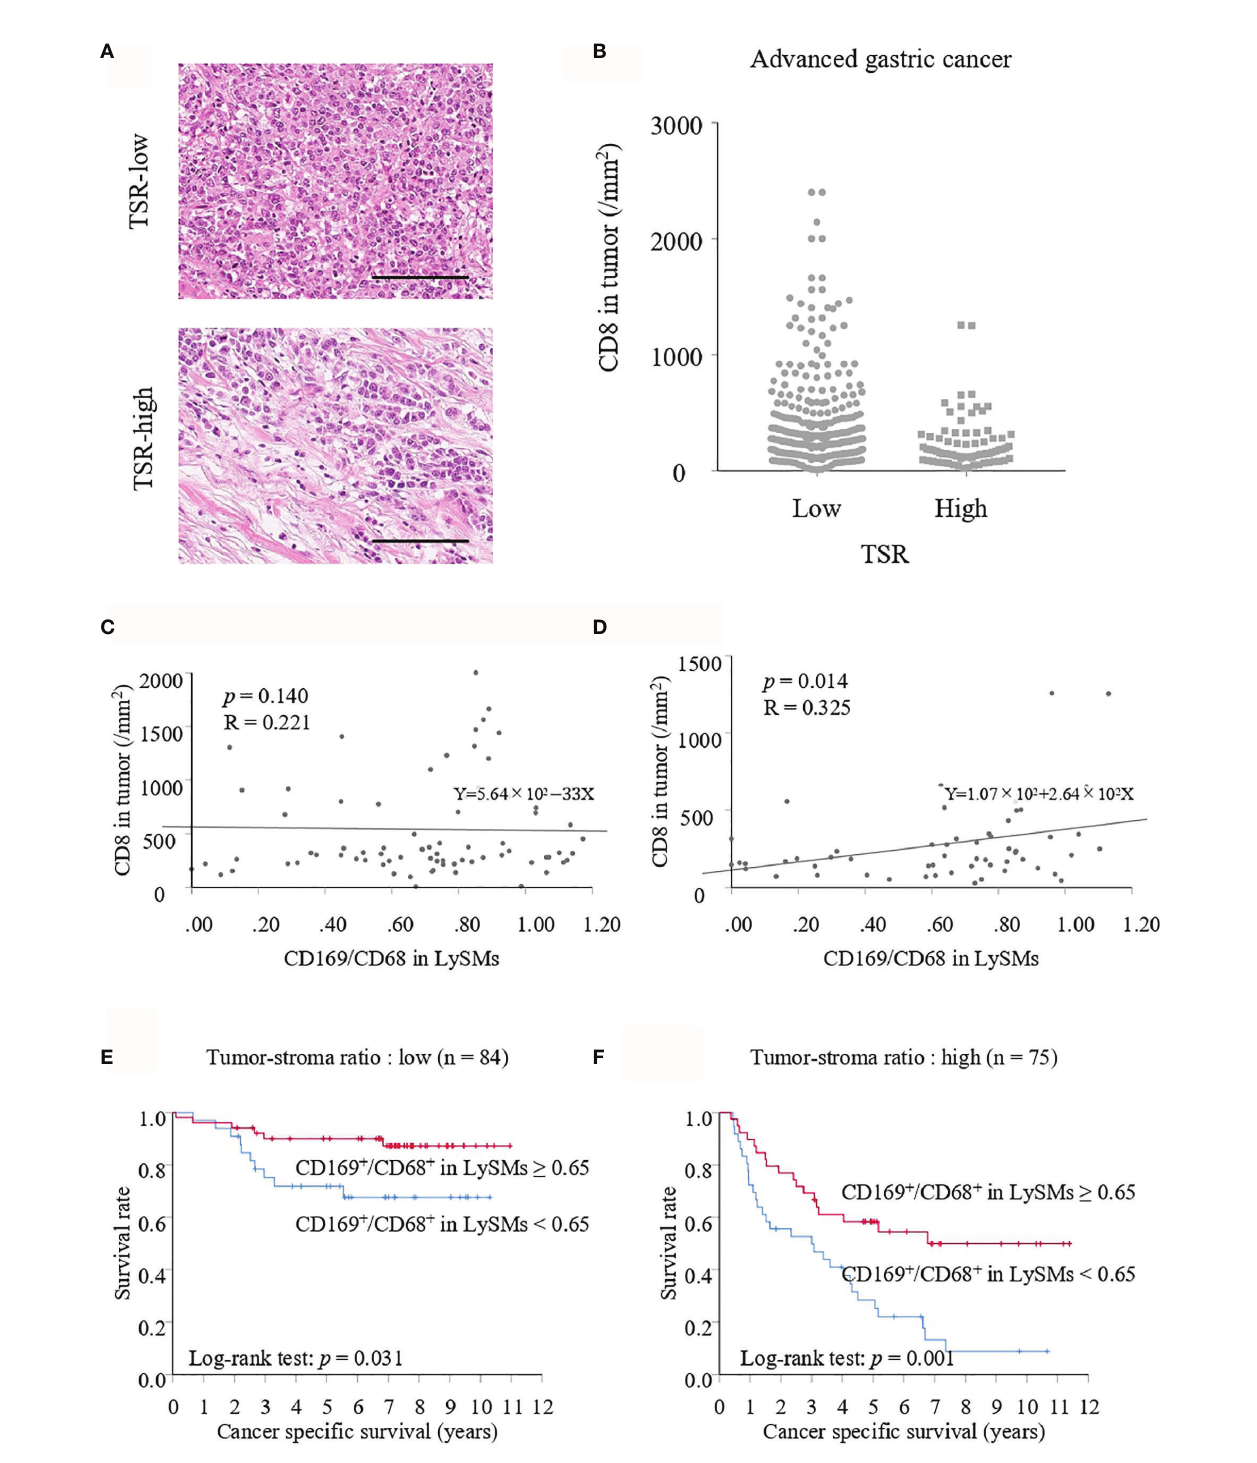
FIGURE 7 | (A) Hematoxylin and eosin staining of tumor-stroma ratio (TSR)- low and high. Scale bar = 100 m m. (B) Number of CD8 + T cells in TSR-low or high advanced cancer tissues. Correlation between the number of CD8 + T cells in TSR-low or high tumor tissues and the CD169/CD68 ratio in lymph node sinus macrophages (LySMs) were tested by Spearman ’ s correlation test. Scatter plot in TSR-low advanced gastric cancer cases (C) and in TSR-high advanced gastric cancer cases (D) were shown. (E) Kaplan-Meier cancer-speci fi c survival (CSS) curves in patients with TSR-low advanced gastric cancer. (F) Kaplan-Meier CSS curves in patients with TSR-high advanced gastric